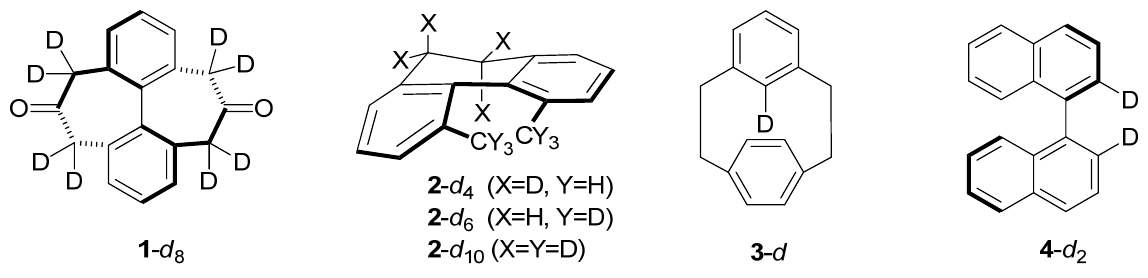
Figure 1. Molecules for which CKIEs have been